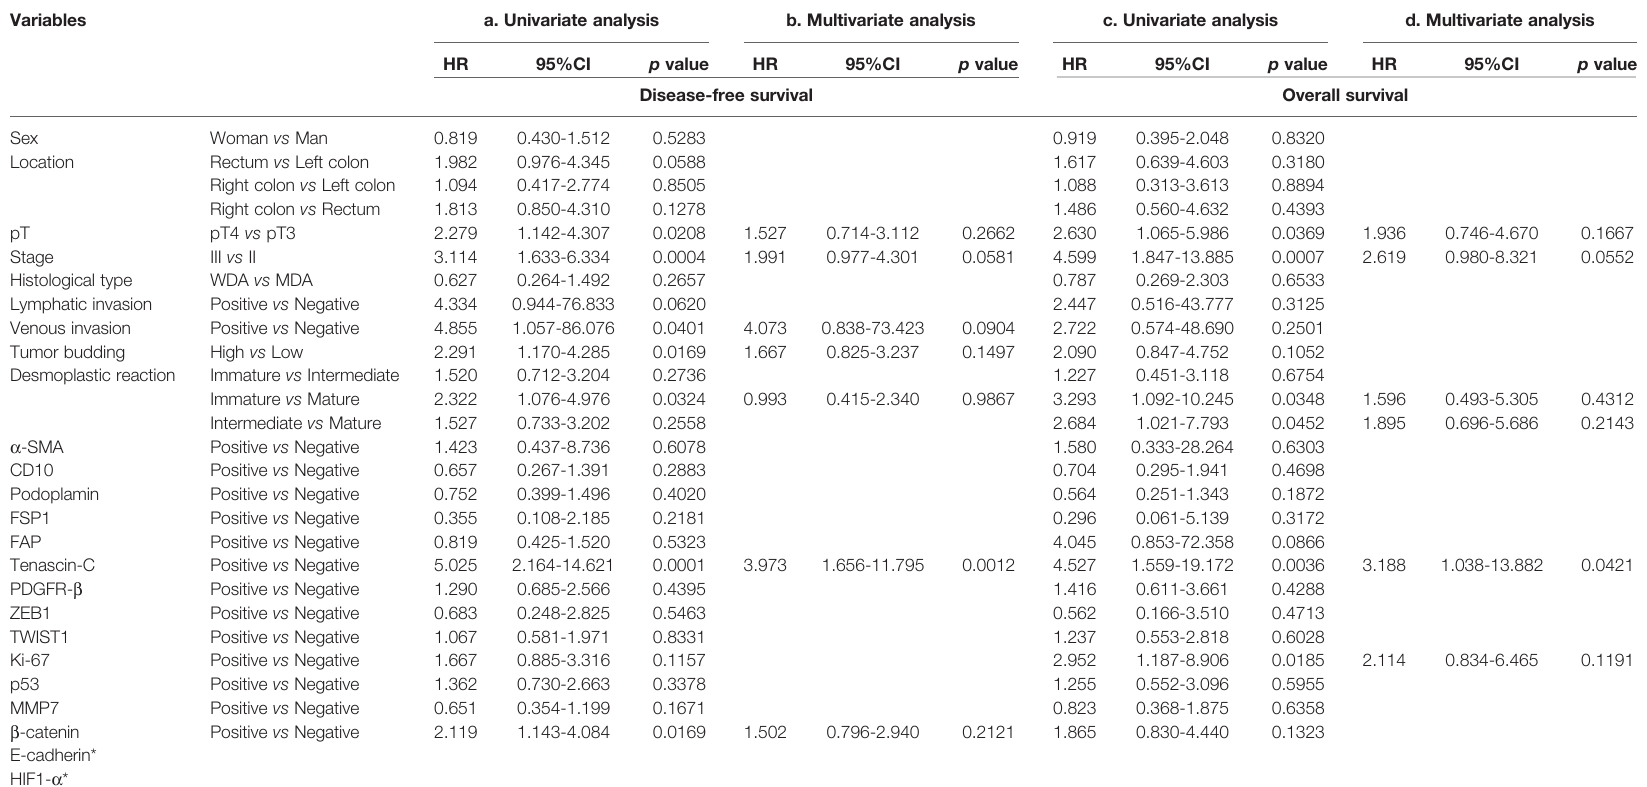
TABLE 5 | Association of clinicopathological variables and individual markers with disease-free survival and overall survival in the second cohort in univariate and multivariate analyses.